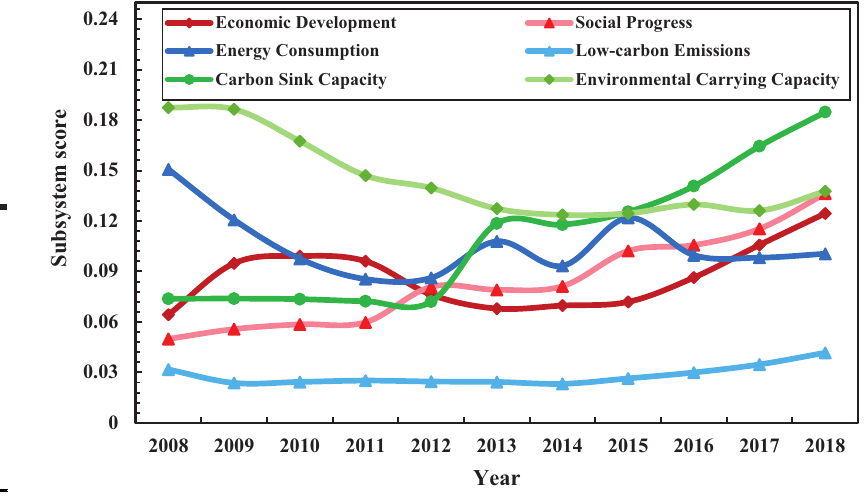
Figure 4. Sichuan province low-carbon circular economic development system